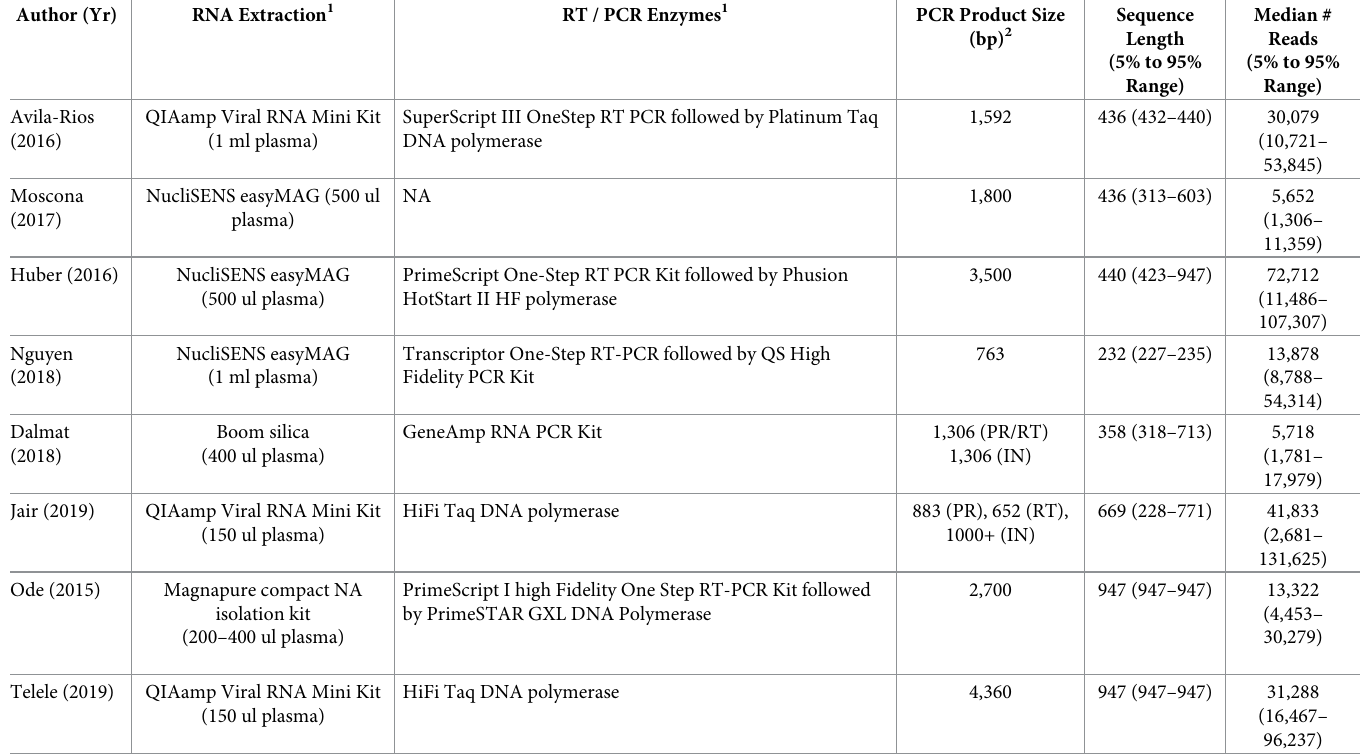
Table 2. Sample preparation methods and median number of sequence reads in eight studies of HIV-1 pol